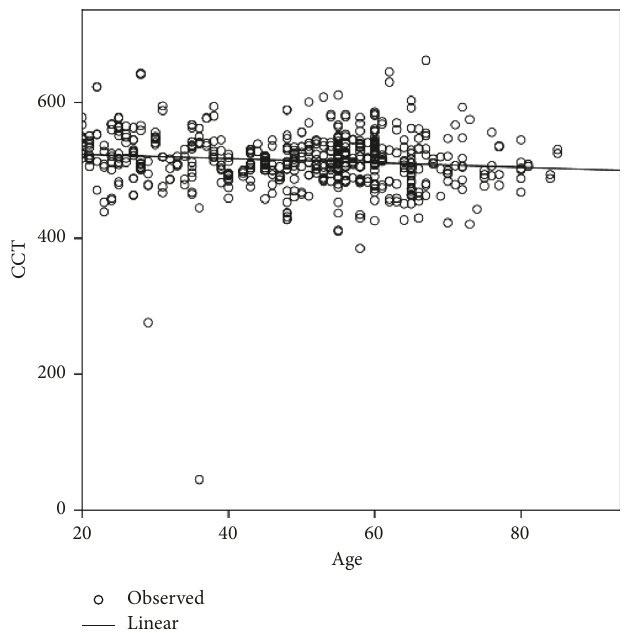
Figure 1: Relationship between the central corneal thickness (CCT) and age in Egyptian subjects with healthy eyes.